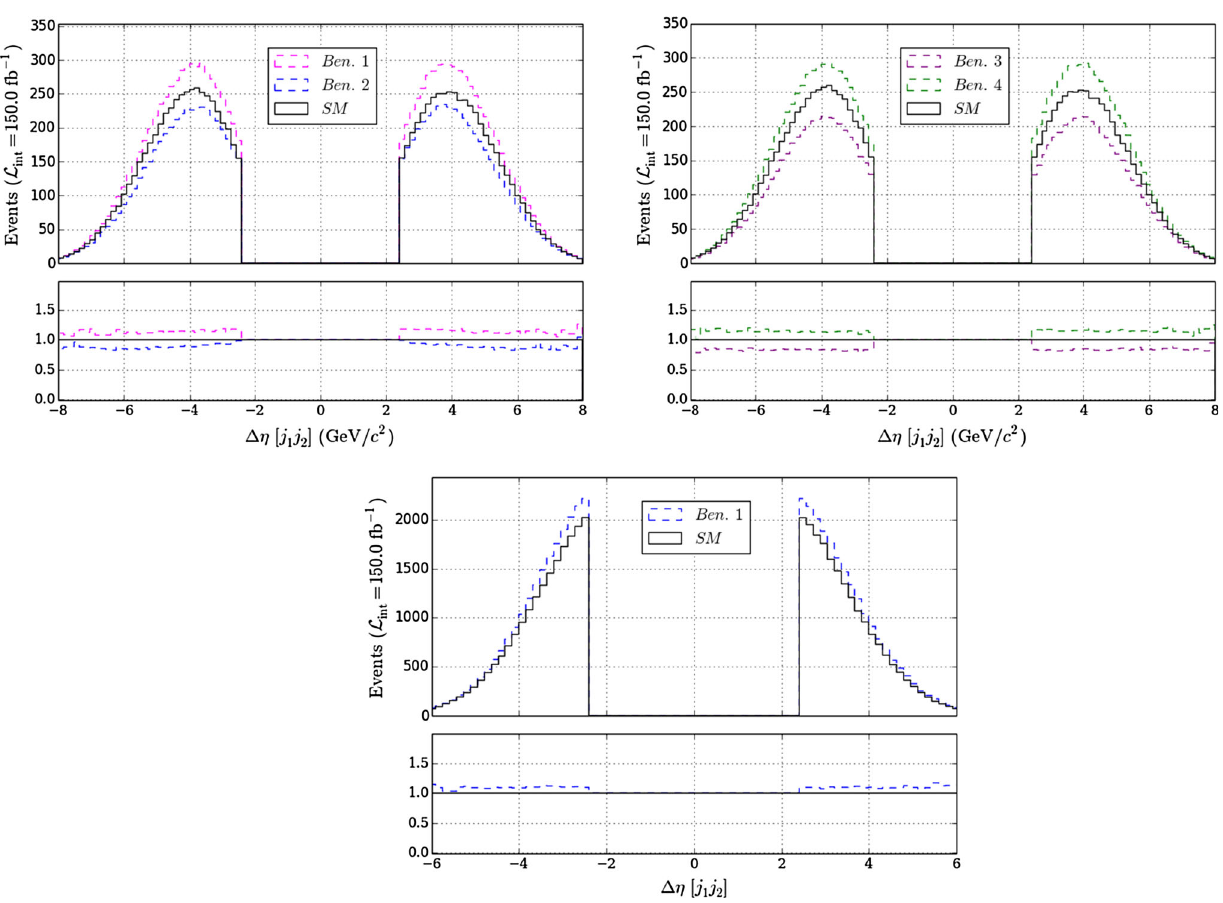
Fig. 9 Top: Bosonic benchmarks (left) and fermionic benchmarks (right). The (cid:7)η variable seems to be a very good flag for new physics effects in VBS, where two rapidity peaks are always observed. Bottom: Effect of the B1 scenario in the background process, discussed in Sect.